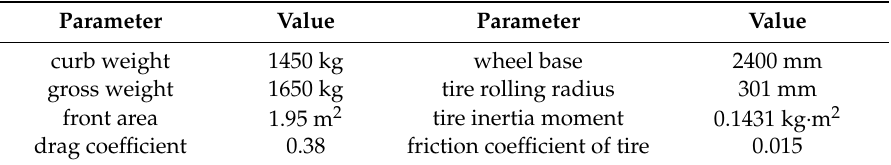
Table 1. Vehicle basic parameters.